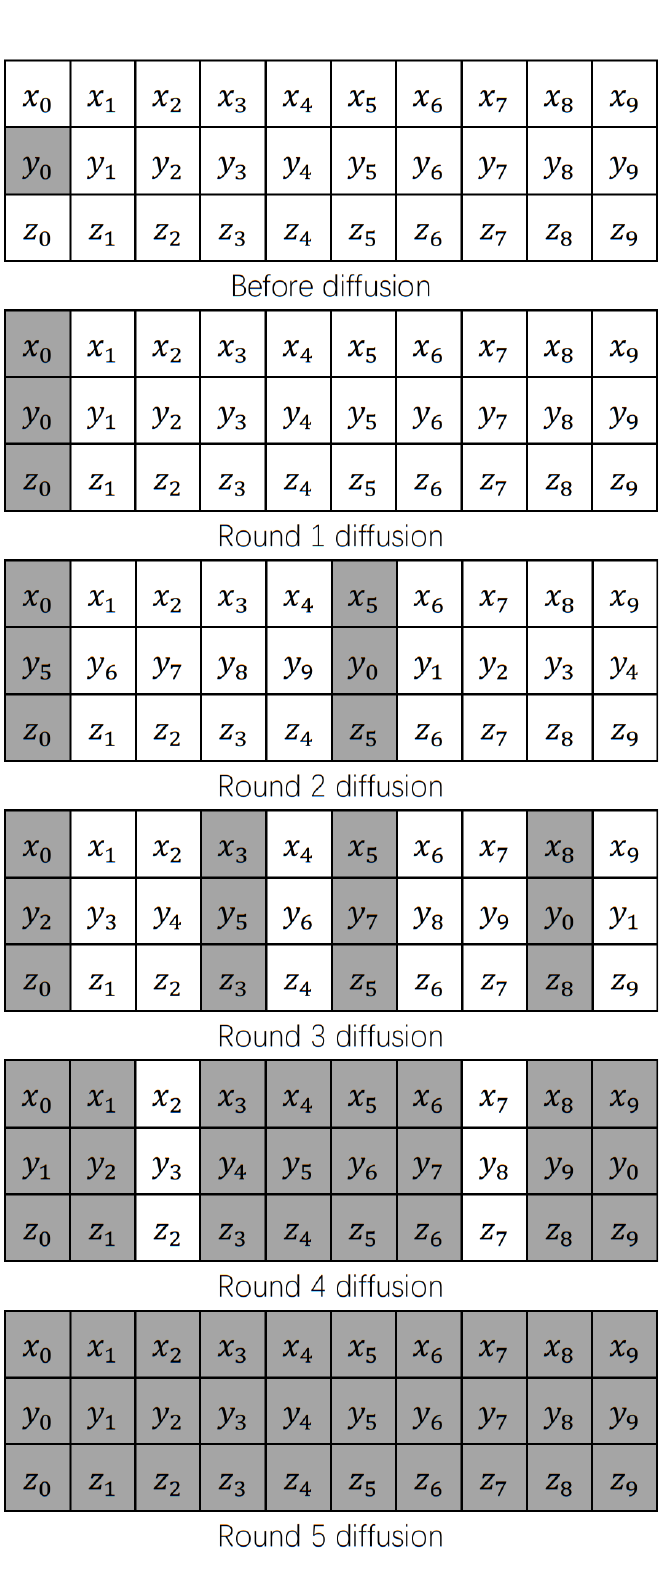
Figure 5. Diffusion